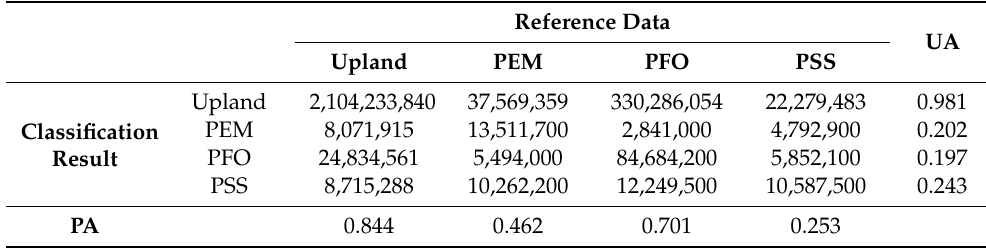
Table 7. Results for multiclass classification with a distance weighting index of 0 (equivalent to traditional accuracy assessment, with uniform weighting of all pixels). OA = 0.824, Kappa = 0.297, AD = 0.046, QD = 0.130.